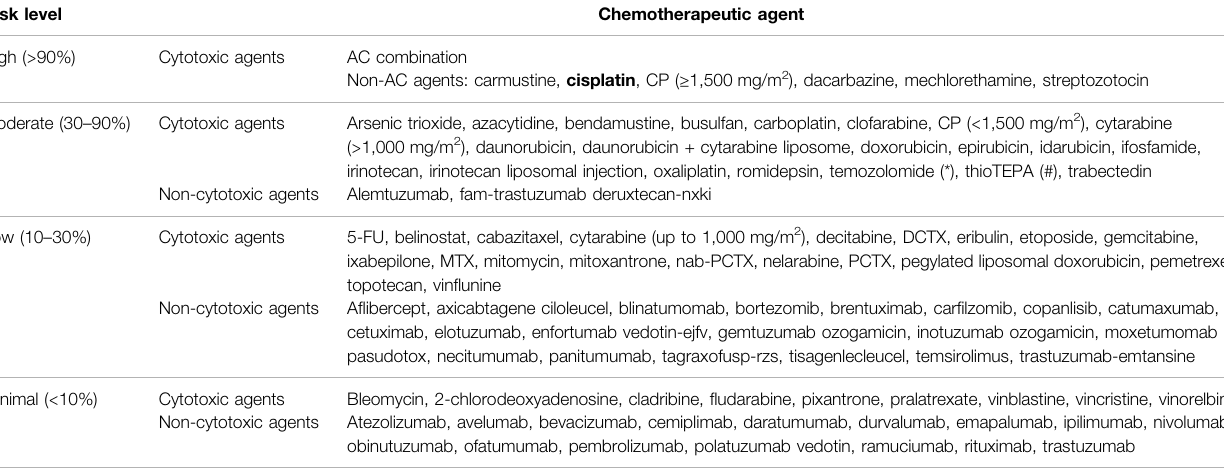
TABLE 4 | Classi fi cation of chemotherapeutic agents according to their emetogenicity. Risk